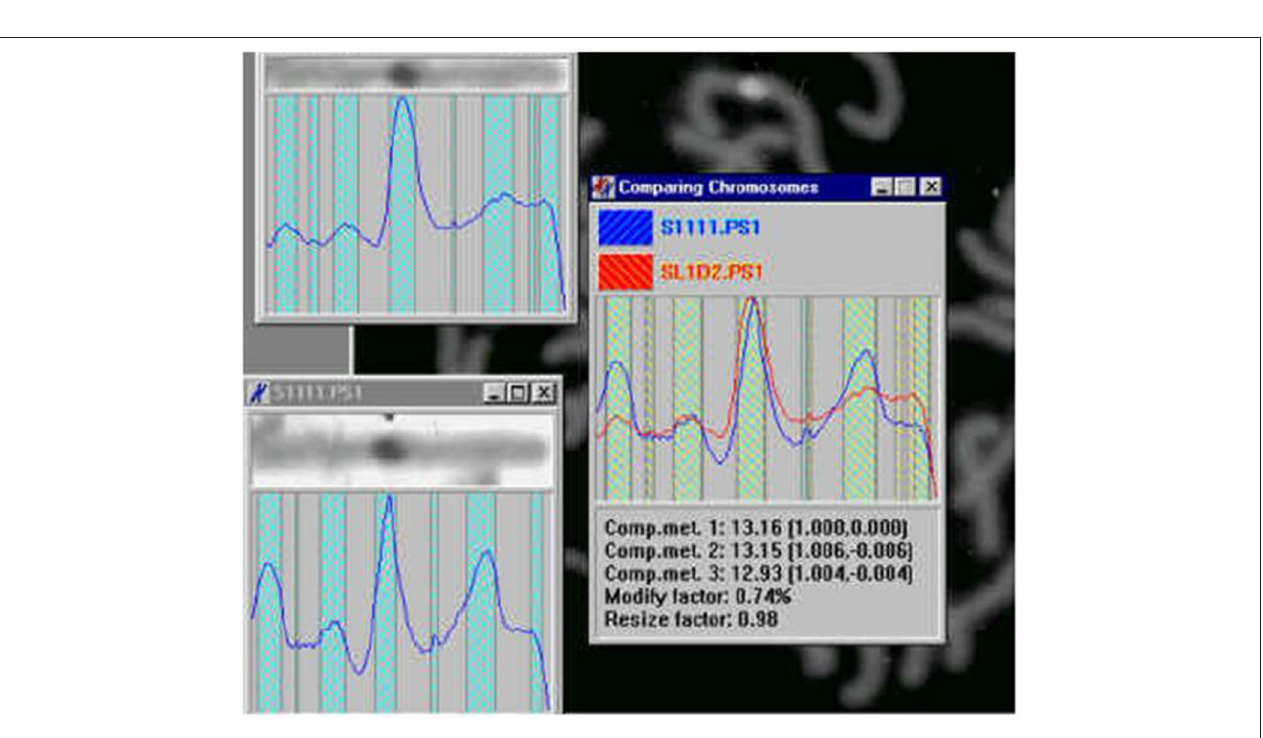
FIGURE 20 | Chromosome measurement, comparison and classification (Jovanovi´c, 2001; Jovanovi´c et al.,